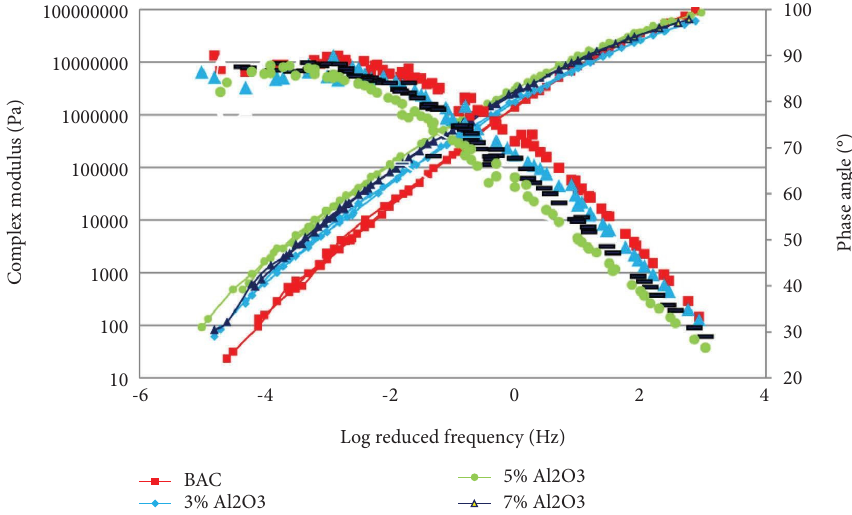
Figure 6: Te efects of the modifer on the phase angle and complex modulus of